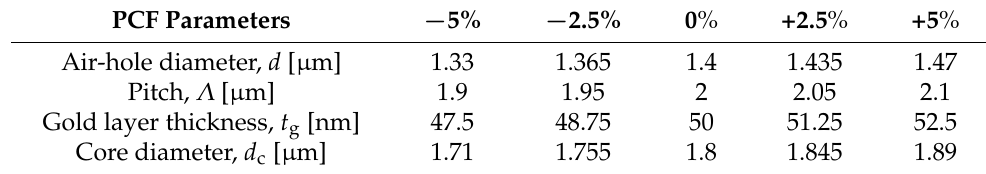
Table 6. Five-level Four Parameters ( ± 5% variations) and their values for DoE CCD Analysis.